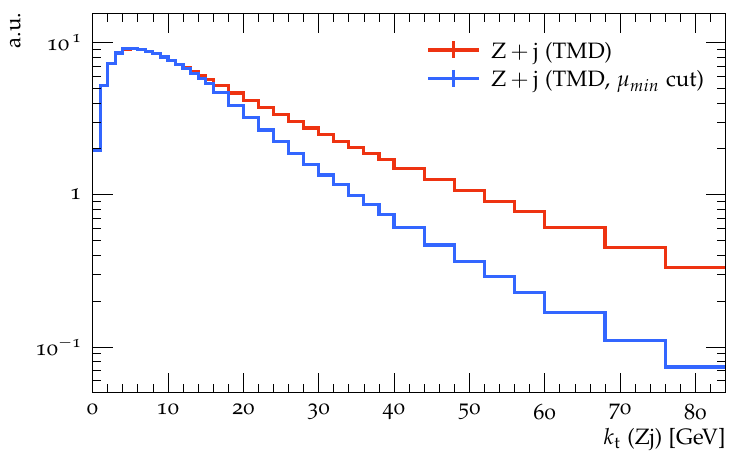
Figure 5 . Transverse momentum distribution of a Z +jet partonic system induced by the TMD evolution, with (blue) and without (red) the k 2